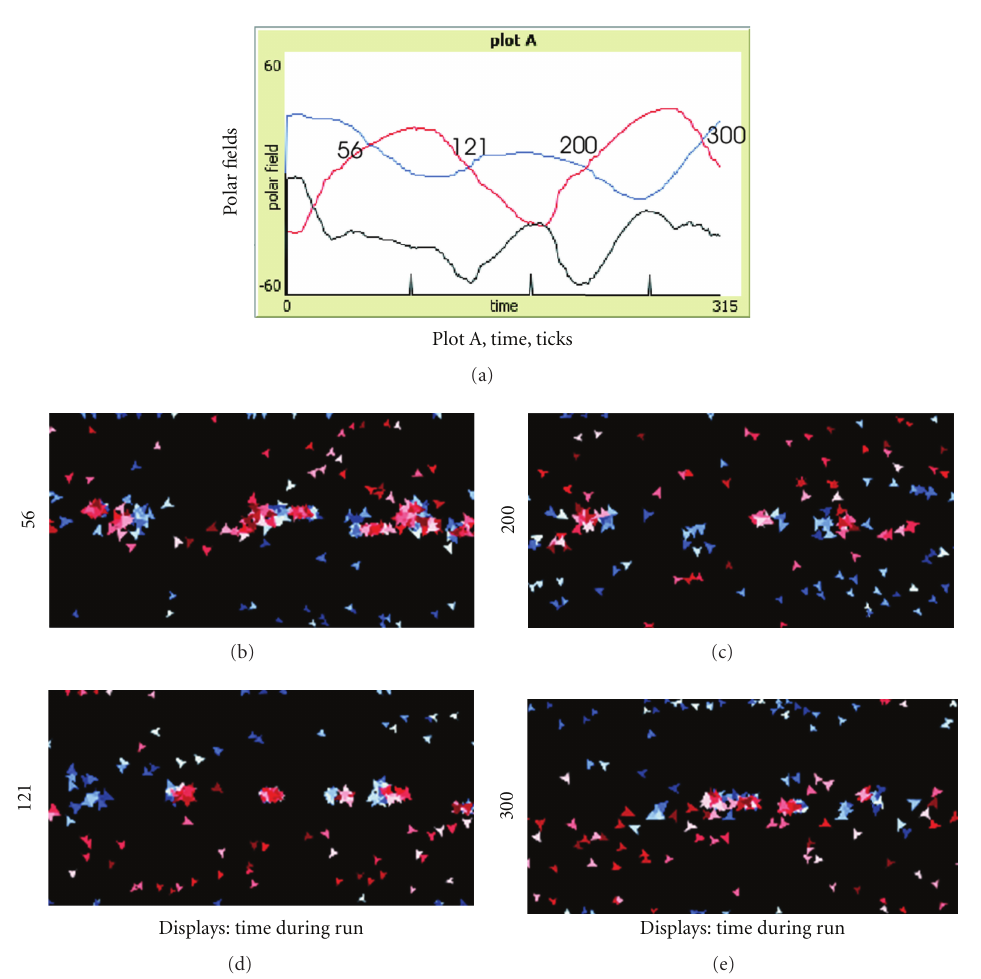
Figure 6: Again the top panel shows the polar field variations during the run for the first few “field reversals,” shown with timesteps at the bottom. Thus again at the top is a Plot A graph with the three colored curves: blue, red, and black. The blue curve displays the amount and sign of the magnetic flux in the northern magnetic pole; the red curve similarly counts the mean field in the Southern polar region, and the black curve marks the Absolute Value Sum of the red and blue curves, placed 60 units downwards, for increased clarity. It essentially reaches a peak, during a solar cycle minimum. The lower panels are the field maps at these times, just prior to the complete reversal. One sees the new polar field rising from below, and the old polar field, on the verge of total annihilation. As mentioned in the text, the new fields are gradually marching to the poles. If one were to view the Sun’s limbs at these times, the border between old and new polar field would have a dark filament at high latitude, circling the poles, with the demarcation line being the old and new field boundaries.